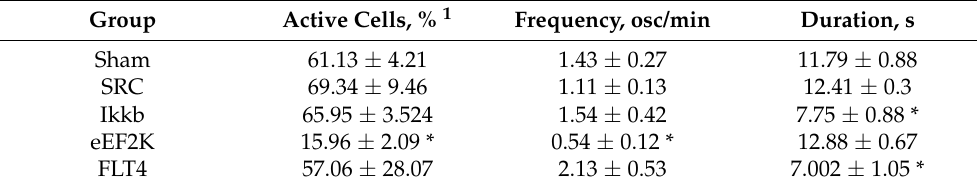
Figure 3. Morphology of primary hippocampal cultures on day 21 of cultivation in vitro. Green, stained by a marker of neuronal protein (MAP2); red, marker of cytoskeleton protein of differentiated astrocytes (GFAP). ( A ) Sham. ( B ) Hypoxia. ( C ) Glucose deprivation. ( D ) Hypoxia + FLT4 blocker. ( E ) Glucose deprivation + FLT4 blocker. Scale bars: 50 µm. Table 2. Main parameters of calcium activity of primary hippocampal cultures together with the blockade of intracellular